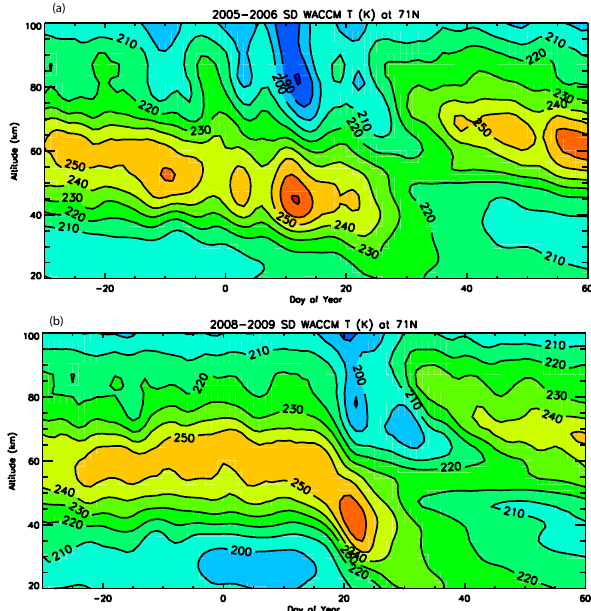
Figure 3. The zonal-mean temperature at 71 ◦ N from December to February end with day of year (DOY) 0 representing 1 January, during (a) the Arctic winter of 2005–2006 and (b)